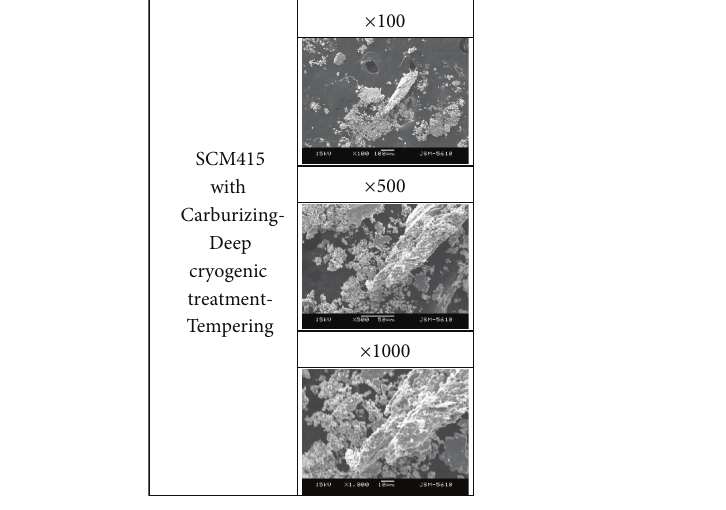
Figure 6: Representative SEM micrographs of wear particle for SCM415 with Carburizing-Deep cryogenic treatment-Tempering.